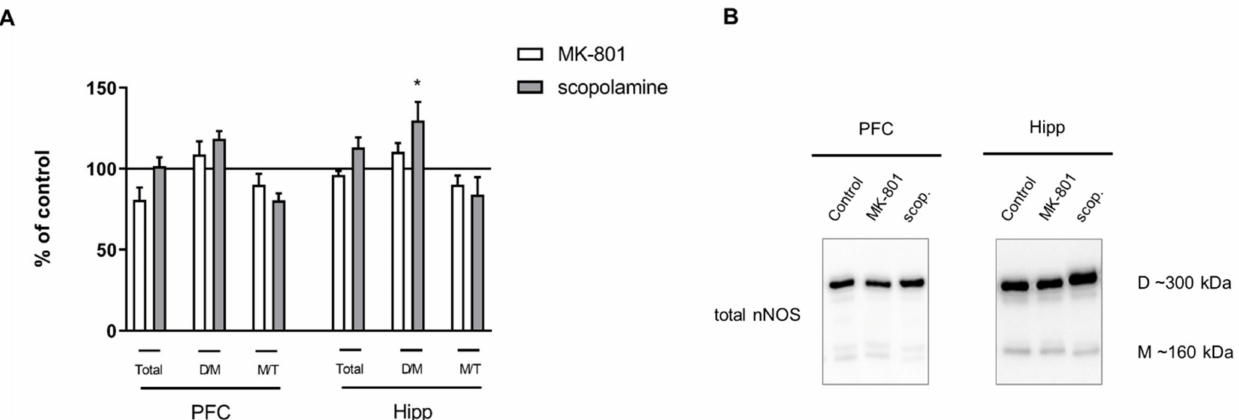
Figure 11. nNOS expression in the prefrontal cortex (PFC) and hippocampus (Hipp) after chronic (14 days) administration of MK-801 (0.3 mg/kg) or scopolamine (1 mg/kg) ( A ). Representative Western blots ( B ). D/M—dimer/monomer ratio; M/T—monomer/total ratio. Data are presented as means ± SEM. * p < 0.05 vs. control. Chronic MK-801 administration decreased the total eNOS protein (F (2.26) = 6.36, p < 0.03) and D/M ratio (F (2.26) = 14.63, p < 0.001) in the PFC. The M/T ratio was in- creased (F (2.27) = 6.7, p < 0.03). Chronic scopolamine treatment induced a decrease in the eNOS D/M ratio (F (2.26) = 14.63, p < 0.001) and an increase in the M/T ratio (F (2.27) = 6.7, p < 0.002) in the PFC (Figure